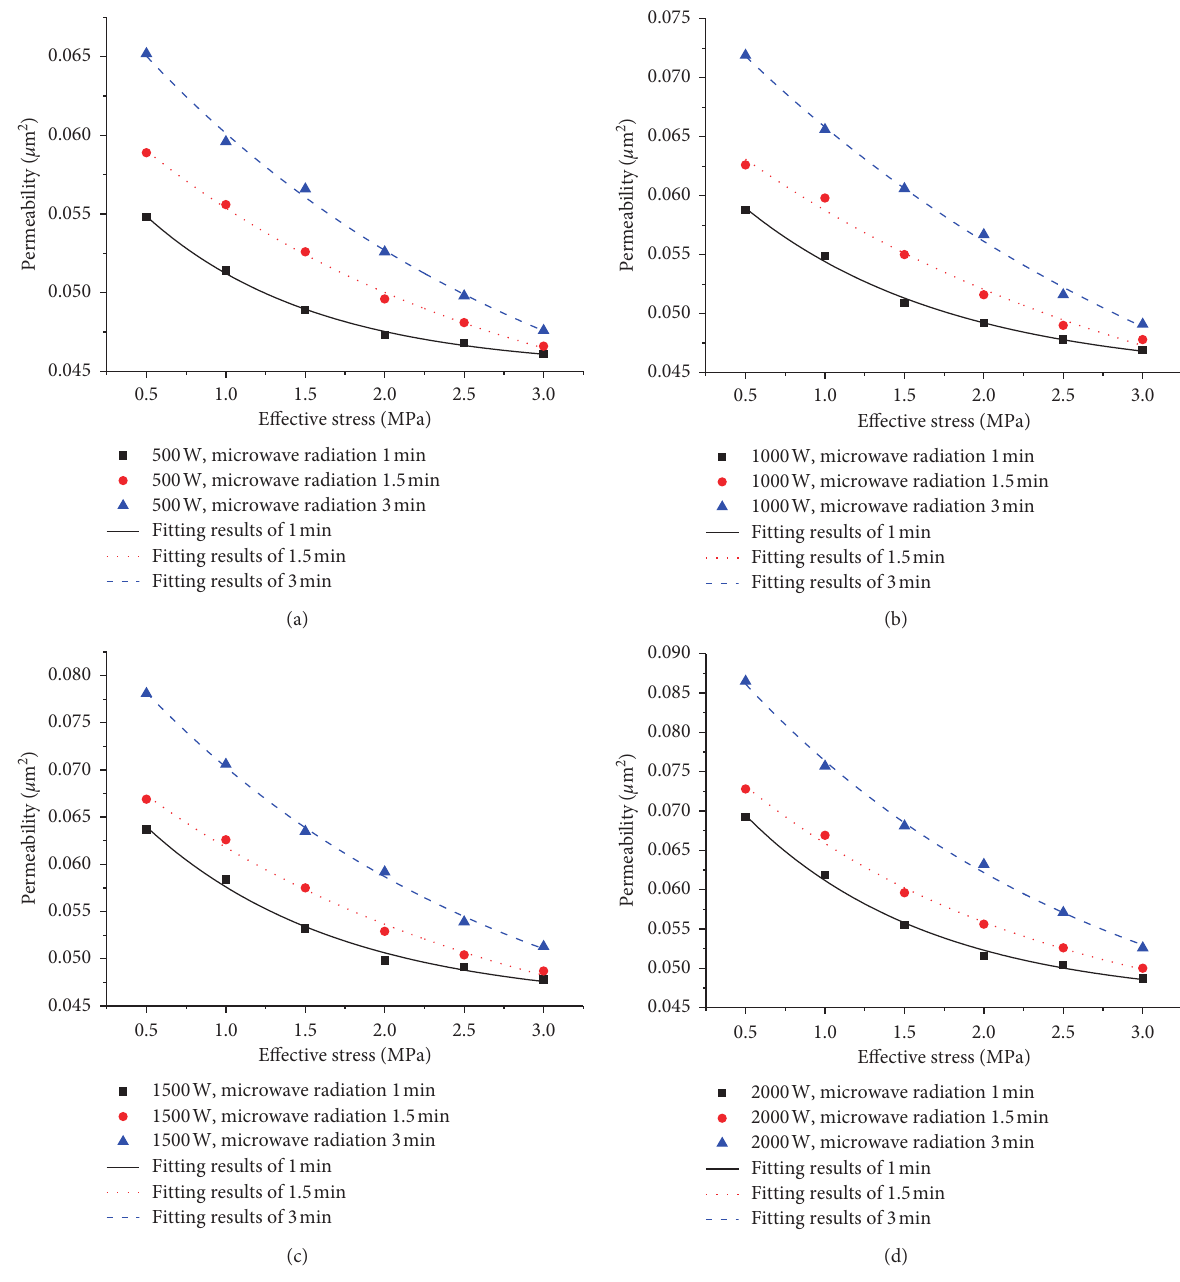
Figure 4: Changes in permeability with irradiation time at a confining pressure of